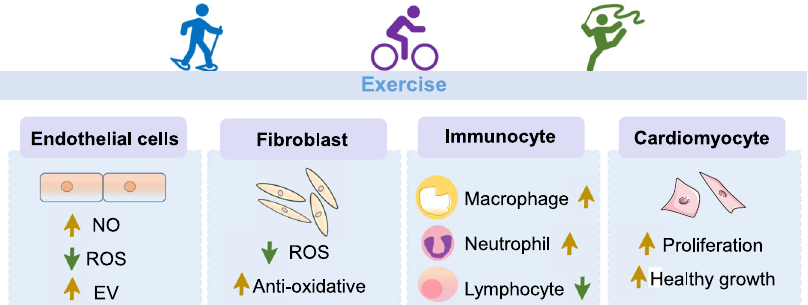
Fig. 2 Cellular adaptions in response to exercise. In endothelial cells, exercise inhibits ROS (reactive oxygen species) production and promotes NO (nitric oxide) production as well as EV (extracellular vesicles) secretion. Exercise also inhibits ROS and improves antioxidative capacity of cardiac fi broblasts. Besides, exercise induces a rapid increase in macrophage and neutrophil number, whereas decrease in lymphocyte number. All these adaptions directly or nondirectly contributes to exercise-induced cardiomyocyte proliferation and physiological